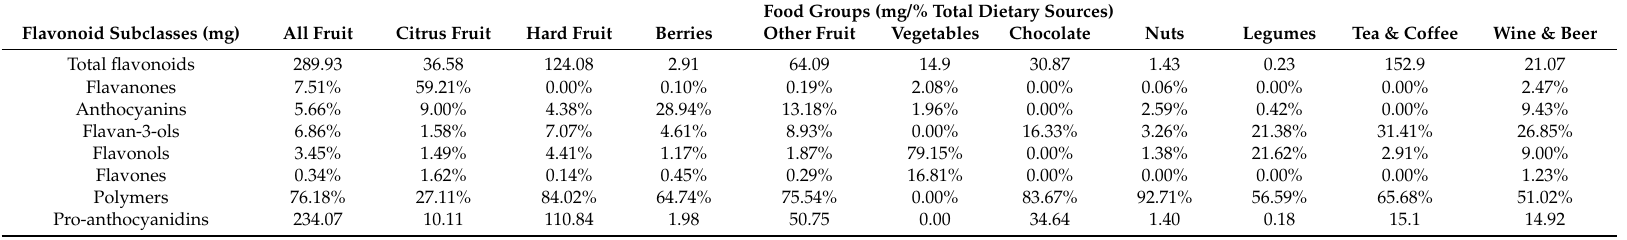
Table 3. Provenance and contribution of flavonoid subclasses in the diet of participants in the GA 2 LEN Follow-Up